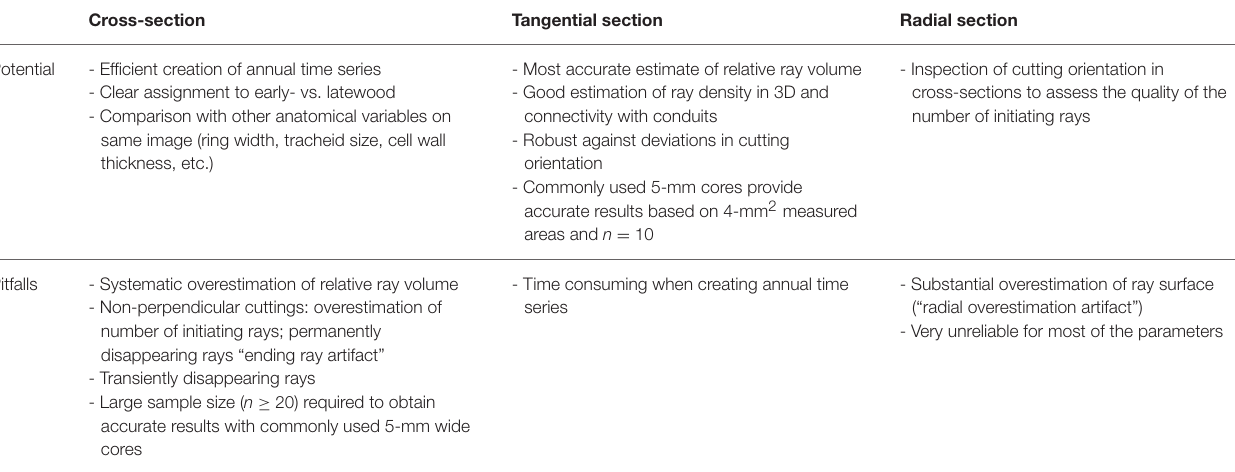
TABLE 2 | Potential and pitfalls of anatomical ray quantification in conifers for different cutting planes. Cross-section Tangential